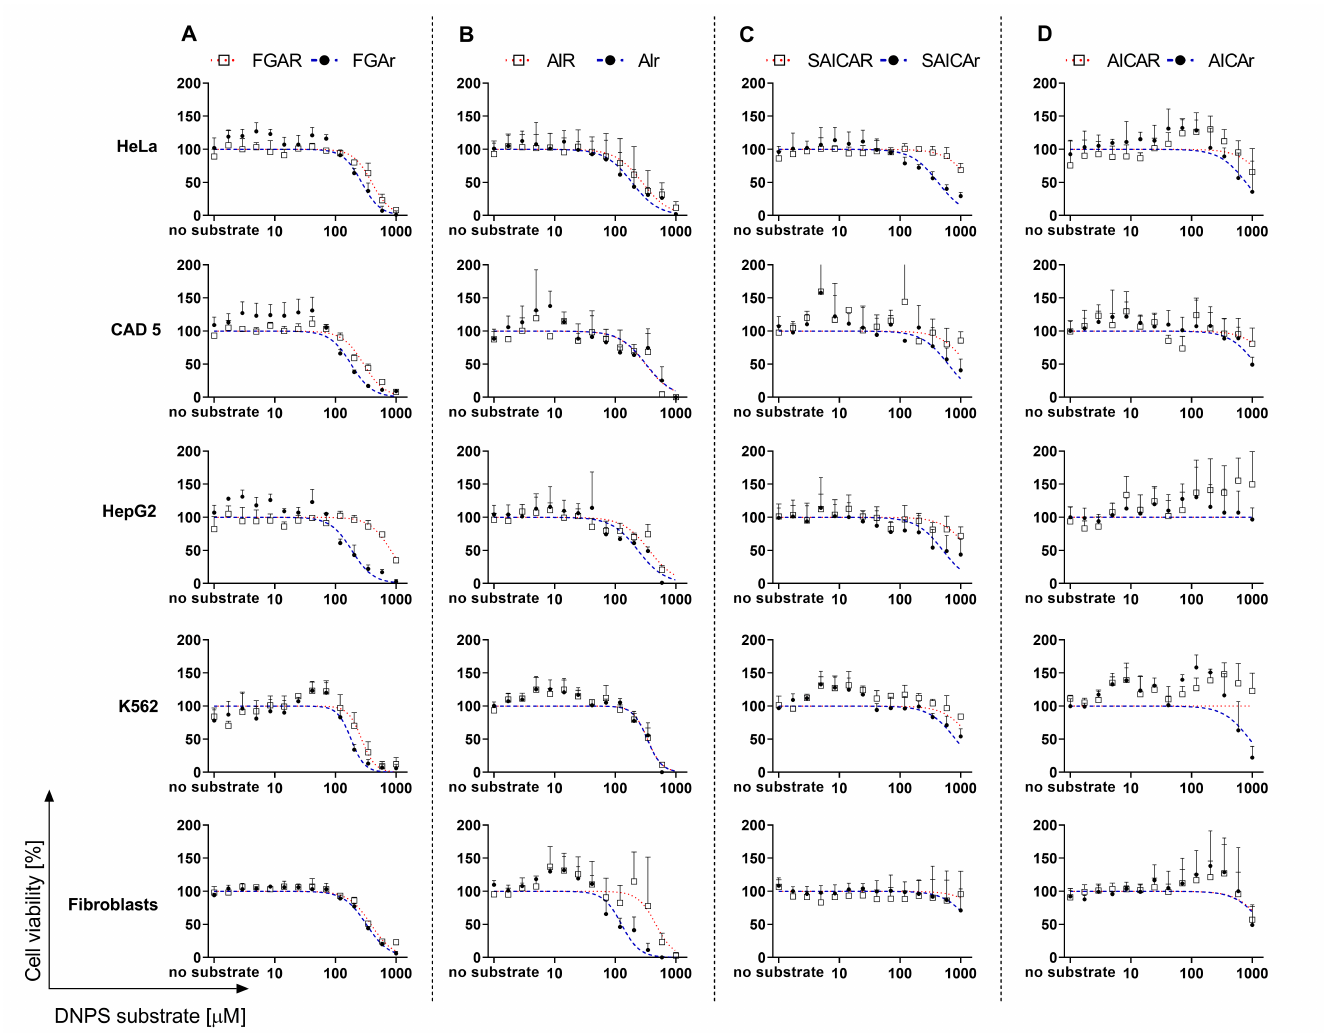
Figure 3. Cytotoxicity of DNPS metabolites (FGAR/r, AIR/r, SAICAR/r, AICAR/r) in HeLa, CAD 5, HepG2, K562 cells and skin fibroblasts. Cells were cultured in normal growth medium containing corresponding phosphorylated (squares, red dotted line) or dephosphorylated (black circles, blue dashed line) DNPS metabolites at 14 concentrations ranging from 1.7 µ mol/l to 1 mmol/L, and cell viability was evaluated 72 h later. Viability curves of ( A ) FGAR and FGAr, ( B ) AIR and AIr, ( C ) SAICAR and SAICAr, and ( D ) AICAR and AICAr were established. The X -axis displays the concentration of the DNPS metabolite [ µ M] and the Y -axis displays the cell viability [%]. The viability level of untreated cells was set as reference and data were normalized to untreated cells and IC 50 values (Table 1) were calculated using GraphPad Prism software. Each data point represents the mean of 3 independent experiments. Vertical bars represent S.D. (n =